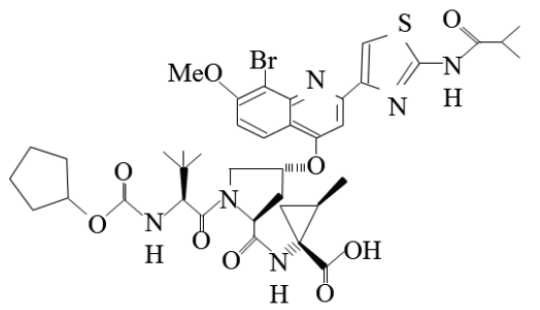
Figure 1. Chemical structure of